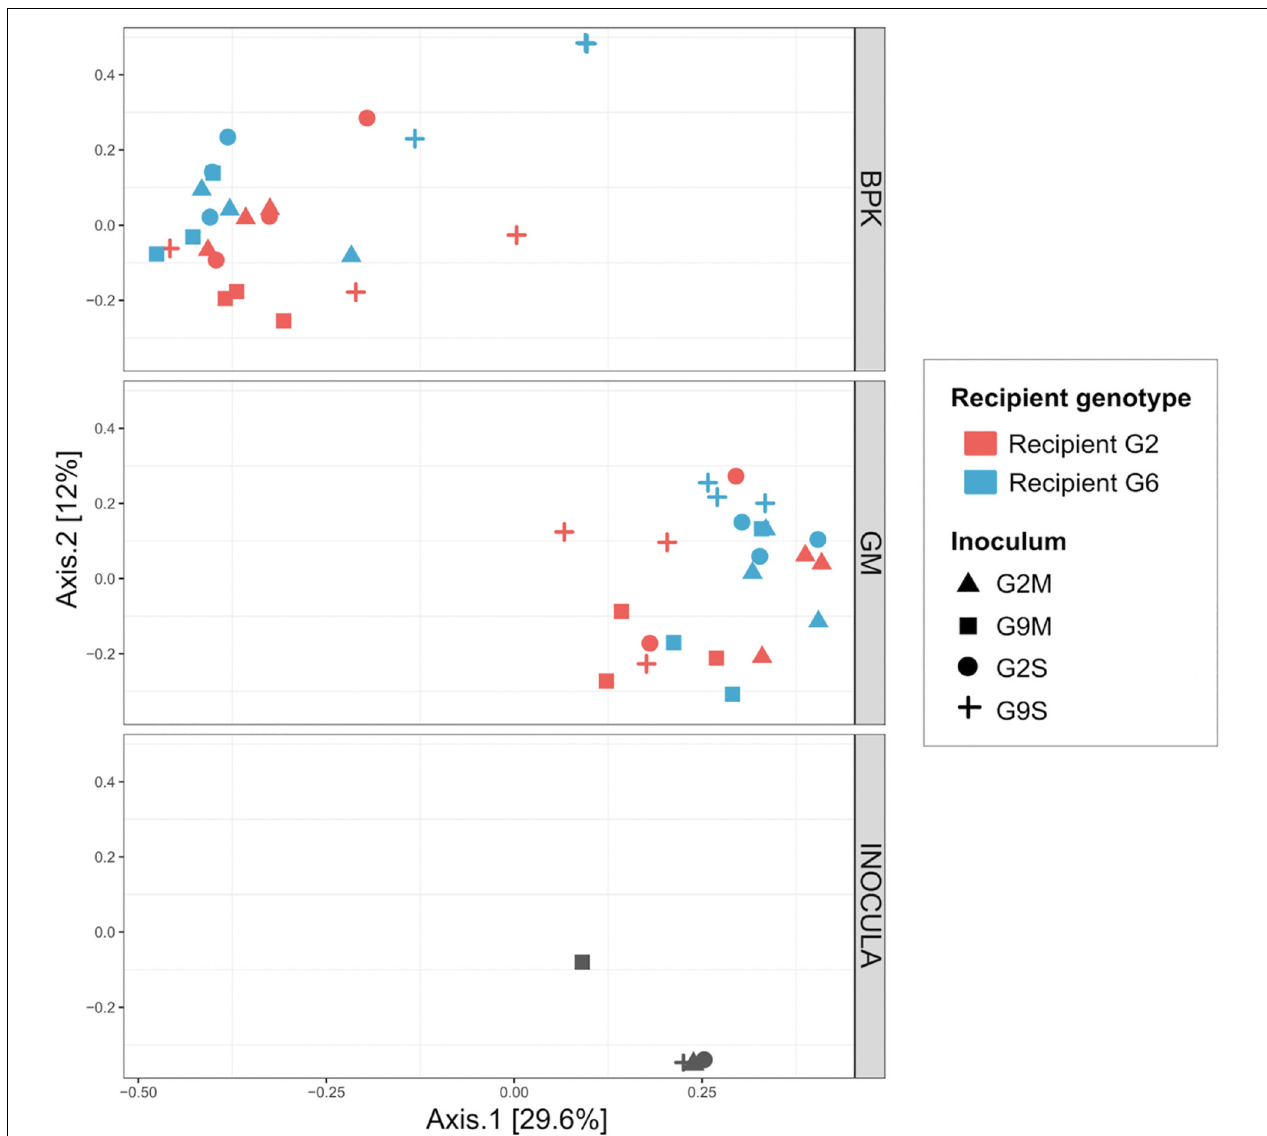
FIGURE 5 | Principal coordinate analysis of microbial communities two weeks after the transplant, using Bray–Curtis dissimilarity indices (Experiment 2). Here, the microbiome inocula used to perform the transplant experiment were included in the analysis. BPK samples, GM samples and microbiome inocula were analyzed together, but are represented on different panels to facilitate